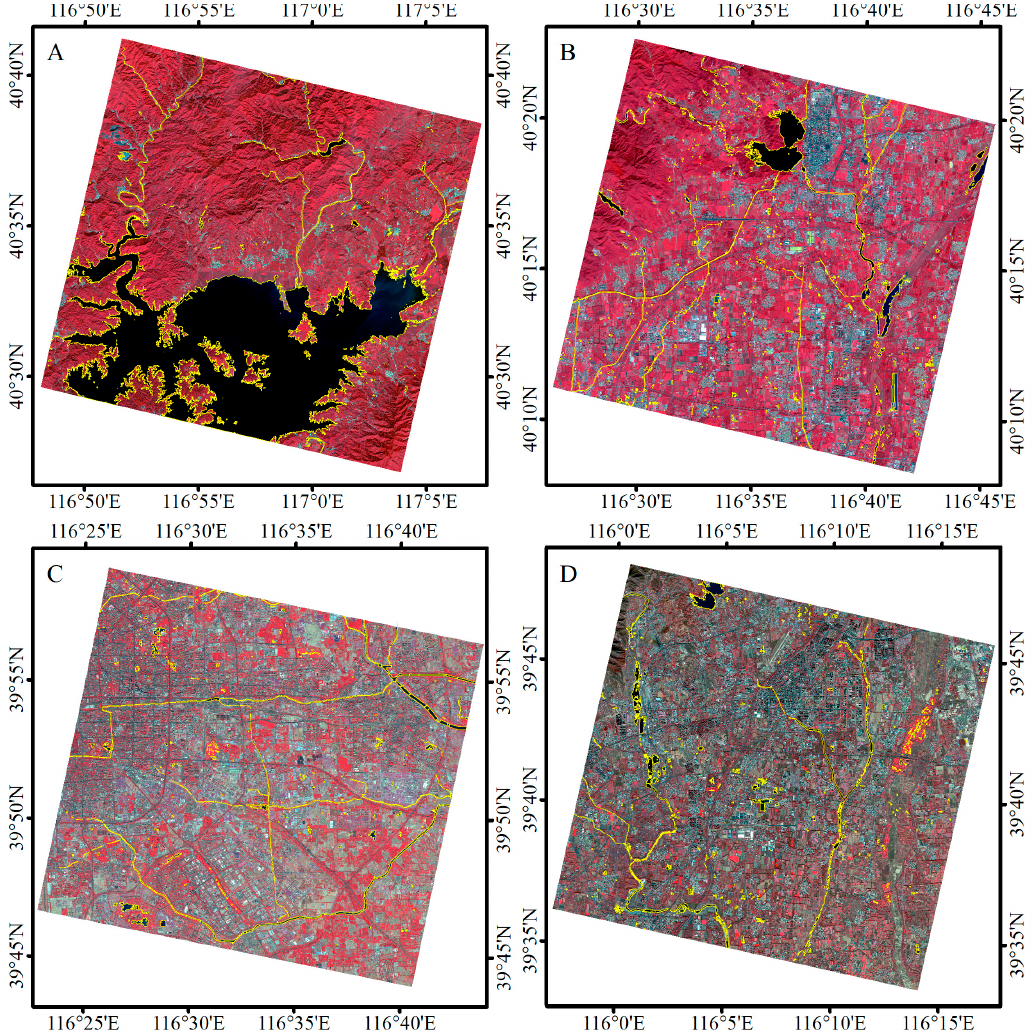
Figure 8. Surface water bodies (black) and extraction results (yellow) for the four testing images ( A – D ) (false color composite, R: Band 4; G: Band 3; B: Band 2).